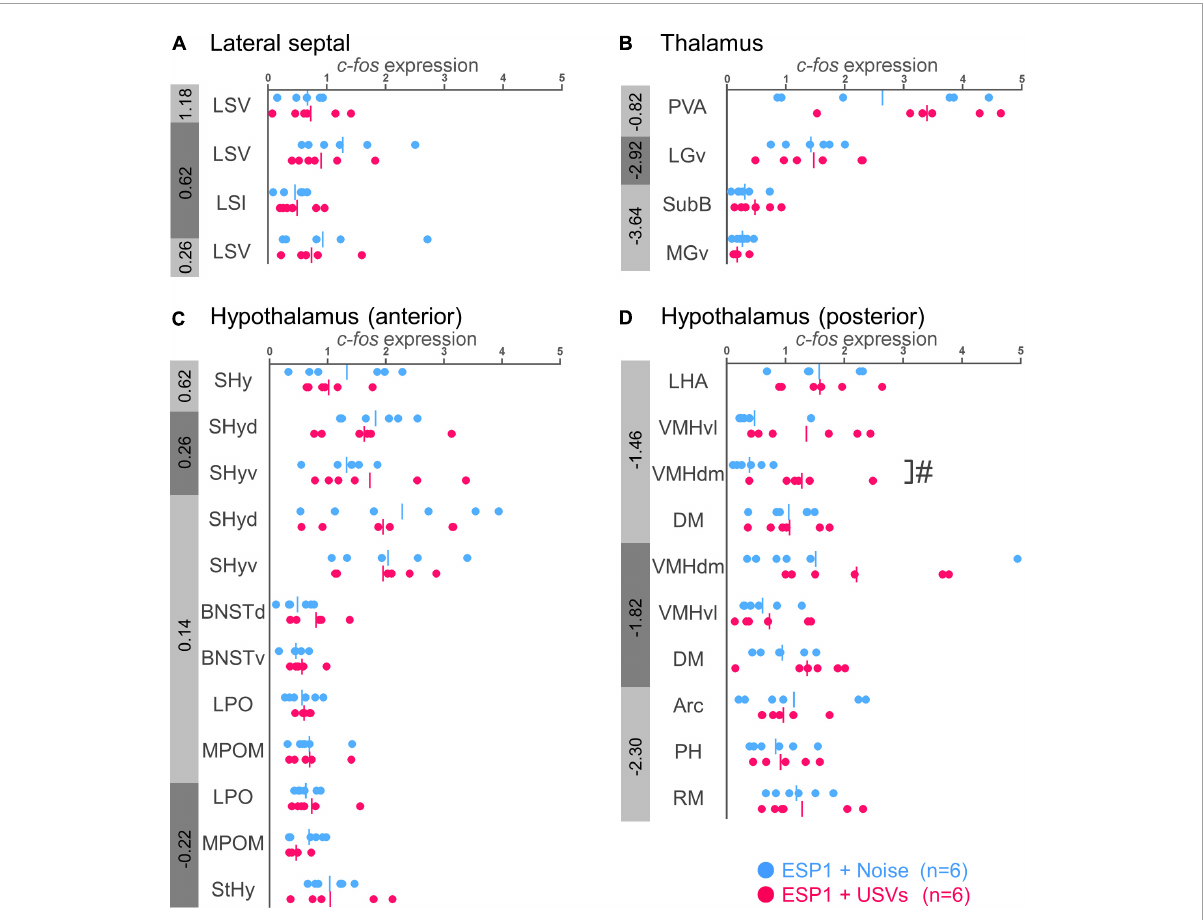
FIGURE3 Expression levels of c-fos mRNA in the lateral septal nucleus (A) , thalamus (B) , and hypothalamus (C,D) of female mice. Blue and red symbols represent individual data for (exocrine gland-secreting peptide 1) ESP1+noise and ESP1+USVs (ultrasonic vocalizations) conditions, respectively. Vertical lines indicate mean values. Numbers in gray bands indicate approximate anteroposterior distance to the bregma (mm). # p < 0.05 (Welch’s t -test; but not significant after multiple comparisons correction). LSV, lateral septal nucleus, ventral part; LSI, lateral septal nucleus, intermediate part; PVA, paraventricular thalamic nucleus, anterior part; LGv, lateral geniculate nucleus, ventral part; SubB, subbrachial nucleus; MGv, medial geniculate nucleus, ventral part; SHy, septohypothalamic nucleus; SHyd, septohypothalamic nucleus, dorsal part; SHyv, septohypothalamic nucleus, ventral part; BNSTd, bed nucleus of the stria terminalis, dorsal part; BNSTv, bed nucleus of the stria terminalis, ventral part; LPO, lateral preoptic area; MPOM, medial preoptic nucleus, medial part; StHy, striohypothalamic nucleus; LHA, lateral hypothalamic area; VMHvl, ventromedial hypothalamic nucleus, ventral part; VMHdm, ventromedial hypothalamic nucleus, dorsomedial part; DM, dorsomedial hypothalamic nucleus; Arc, arcuate hypothalamic nucleus; PH, posterior hypothalamic nucleus; RM, retromammillary